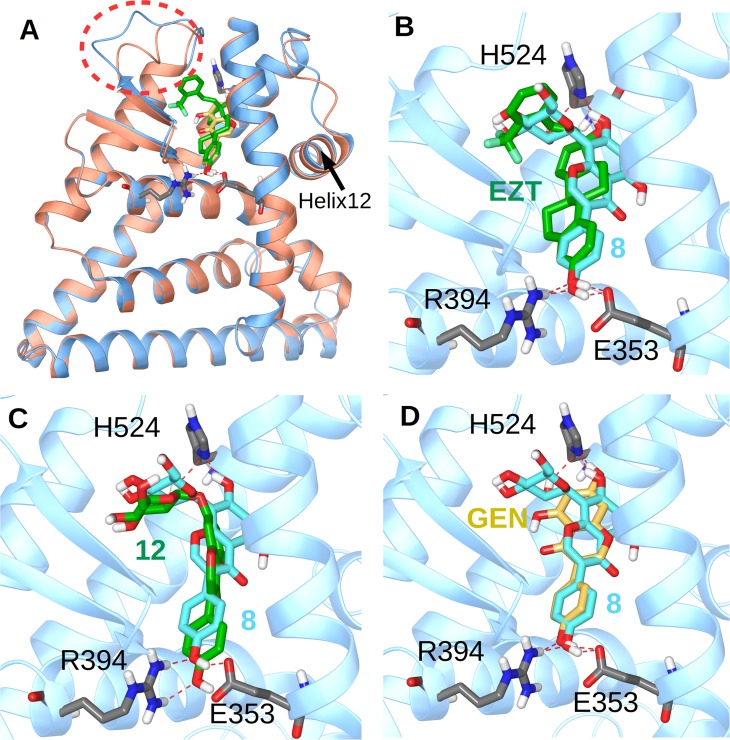
(A) Ribbon representation of ERα in complex with genistein (GEN, orange ribbons) and ortho-trifluoromethylphenylvinyl estradiol (EZT, light blue ribbons). The flexible region which accommodates the bulky group of EZT is inside the red circle. (B) Superposition of crystal structure of EZT with global minimum structure of 8 inside the binding pocket of ERα. (C) Superposition of global minimum structure of 12 with global minimum structure of 8 inside the binding pocket of ERα. (D) Superposition of crystal structure of genistein with global minimum structure of 8 inside the binding pocket of ERα. For clarity reasons Helix 1 has been removed from all figures. Hydrogen bonds are depicted with red dashed lines.